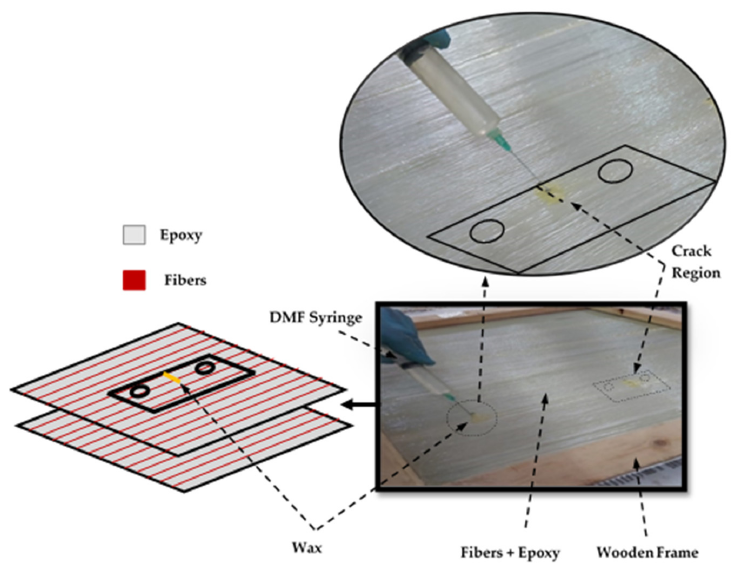
Figure 1. Types of cracks, ( a ) smooth (crack free), ( b ) through thickness crack, and ( c ) matrix crack.